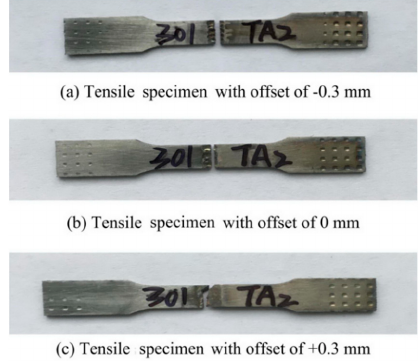
Figure 19. The tensile fracture specimens of 301L/Cu/TA2 welded joints: ( a – c ) tensile specimen with offset of − 0.3 mm, 0 mm and +0.3 mm, respectively.